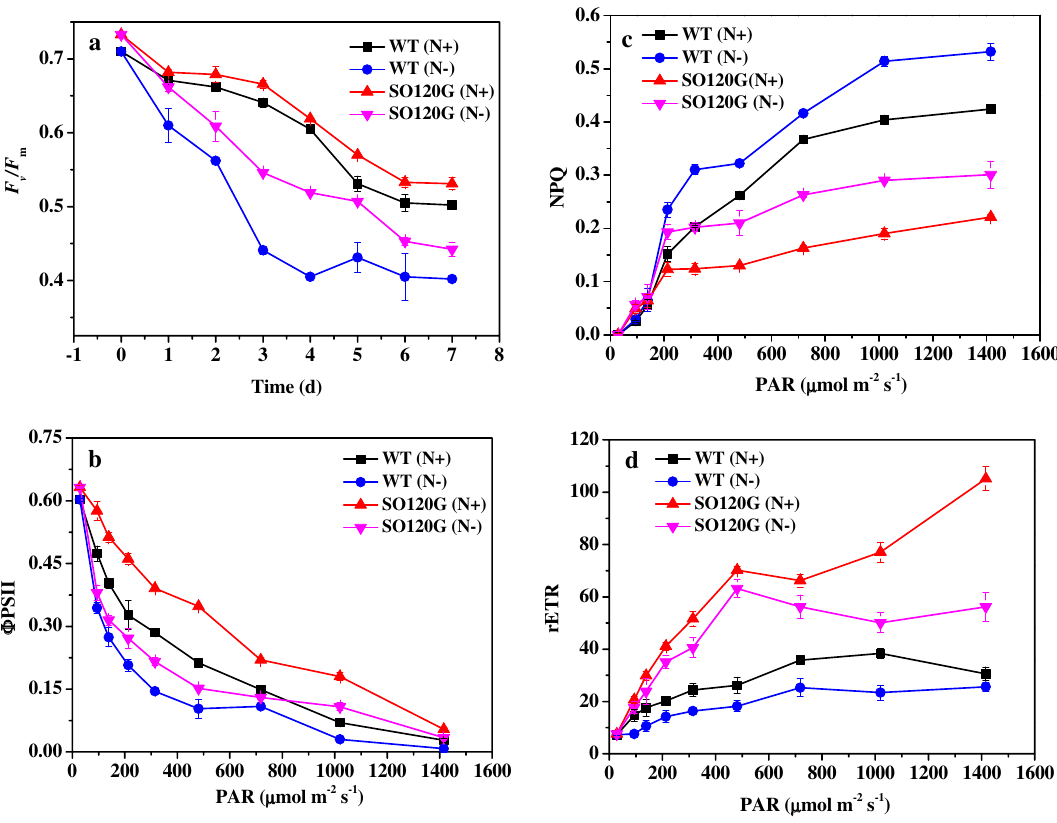
Figure 3. Chlorophyll fluorescence parameters of the WT and SO120G under the N+ and N− culture conditions. ( a ) The F v / F m values of the WT and SO120G; ( b ) the ΦPSII values of the WT and SO120G; ( c ) the NPQ values of the WT and SO120G; and ( d ) the rETR of the WT and